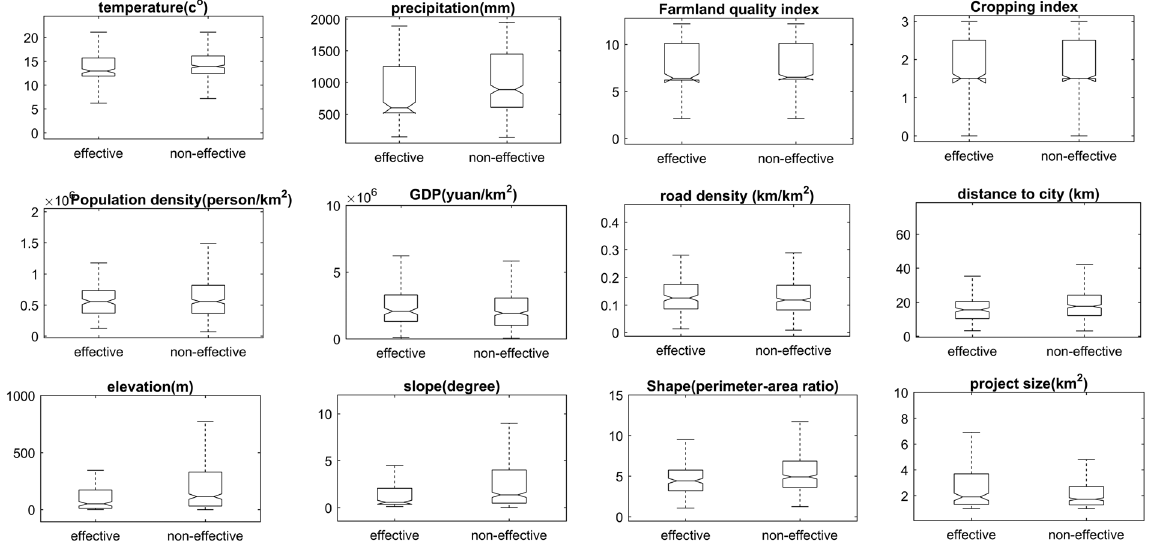
Figure 3. Comparison of selected biophysical and social-economic variables for effective and non-effective sites. Parcels with significant increasing trends in NDVI were considered as effective and the remaining parcels were considered as non-effective.